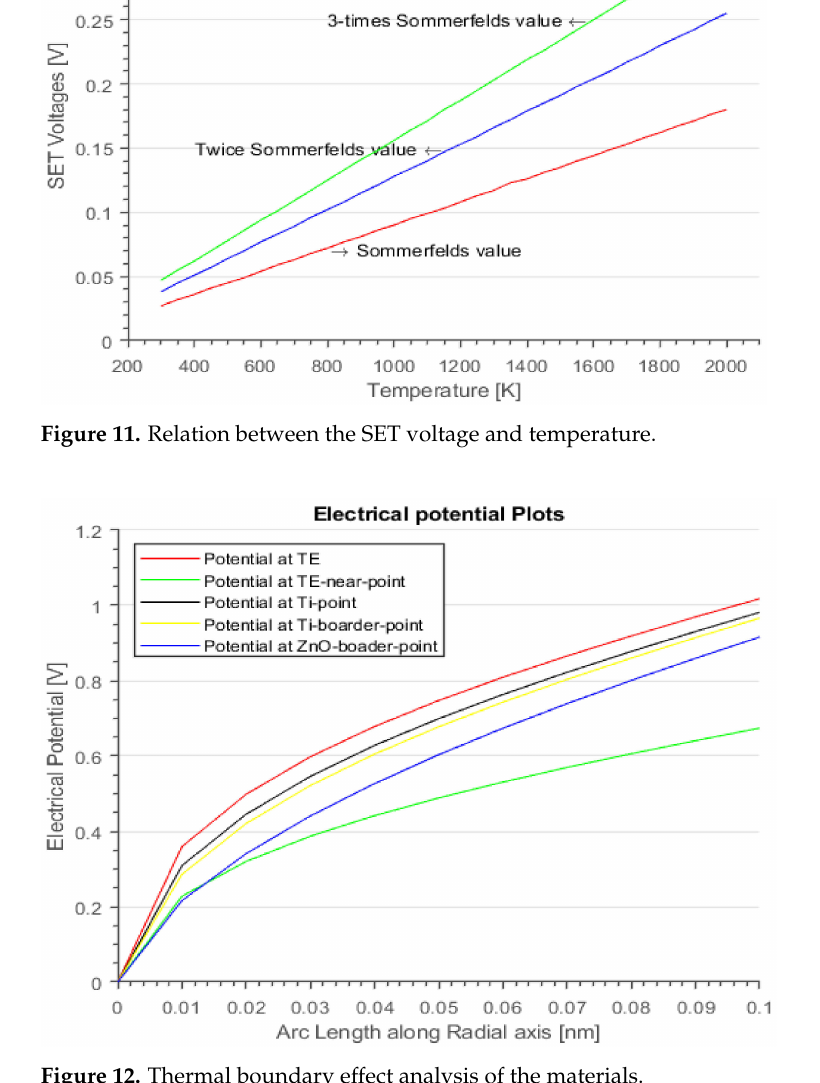
Figure 12. Thermal boundary effect analysis of the